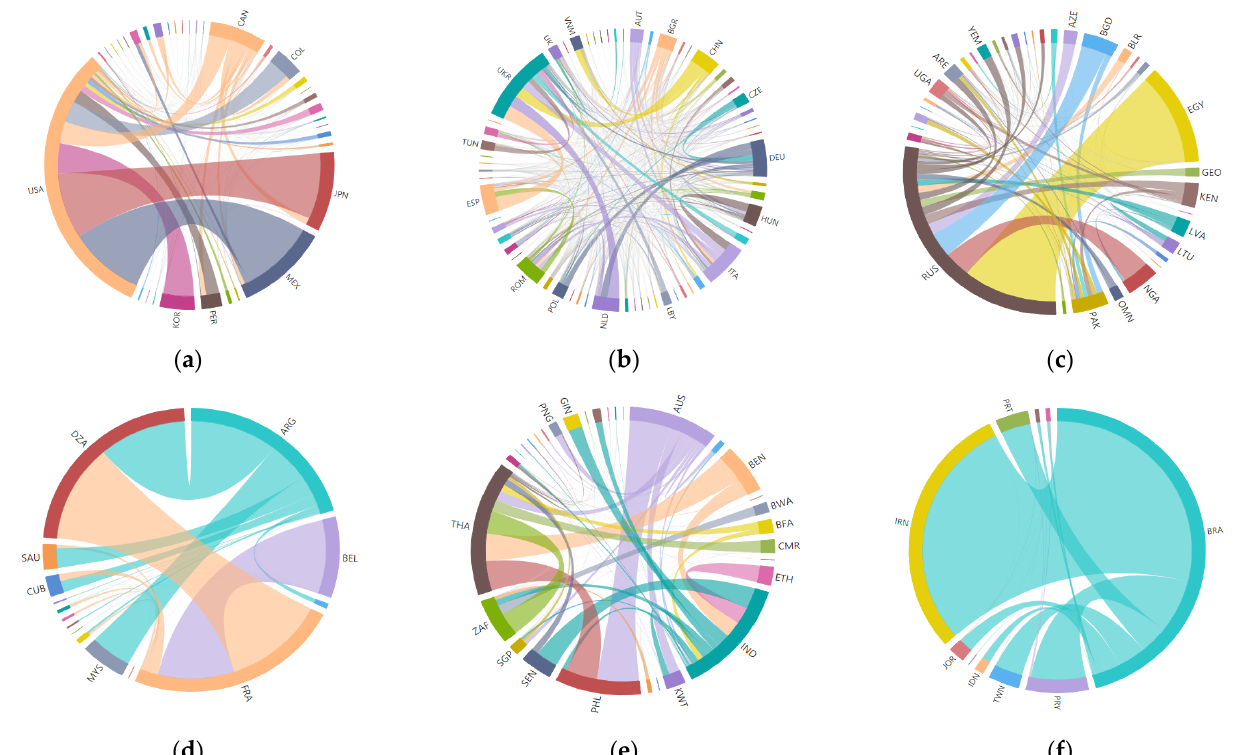
Figure 7. Internal structure of different communities of the global FTN in 2018. ( a ) The USA community; ( b ) UKR–ESP community; ( c ) RUS community; ( d ) ARG–FRA community; ( e ) THA–IND community; ( f ) BRA–IRN community. The thicker the connection line, the greater the volume of trade between the two countries and the closer the trade connection.